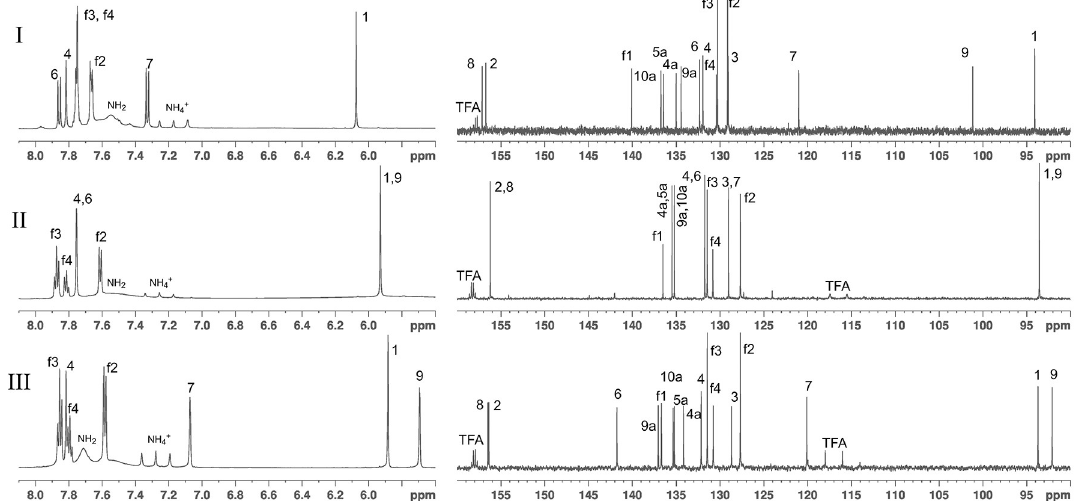
Fig 3. One-dimensional 1 H (left) and 13 C (right) spectra and resonance assignments, exclusive of the methyl region, in DMSO-d6 of safranines